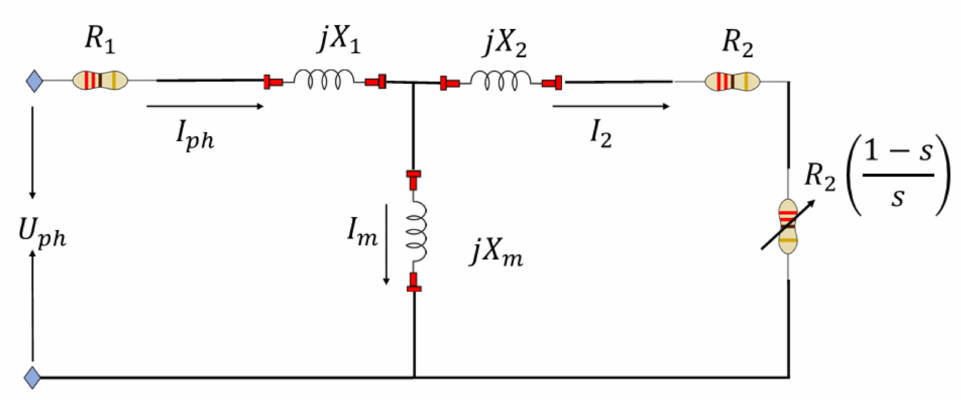
Figure 1. T-type equivalent circuit of an AC induction